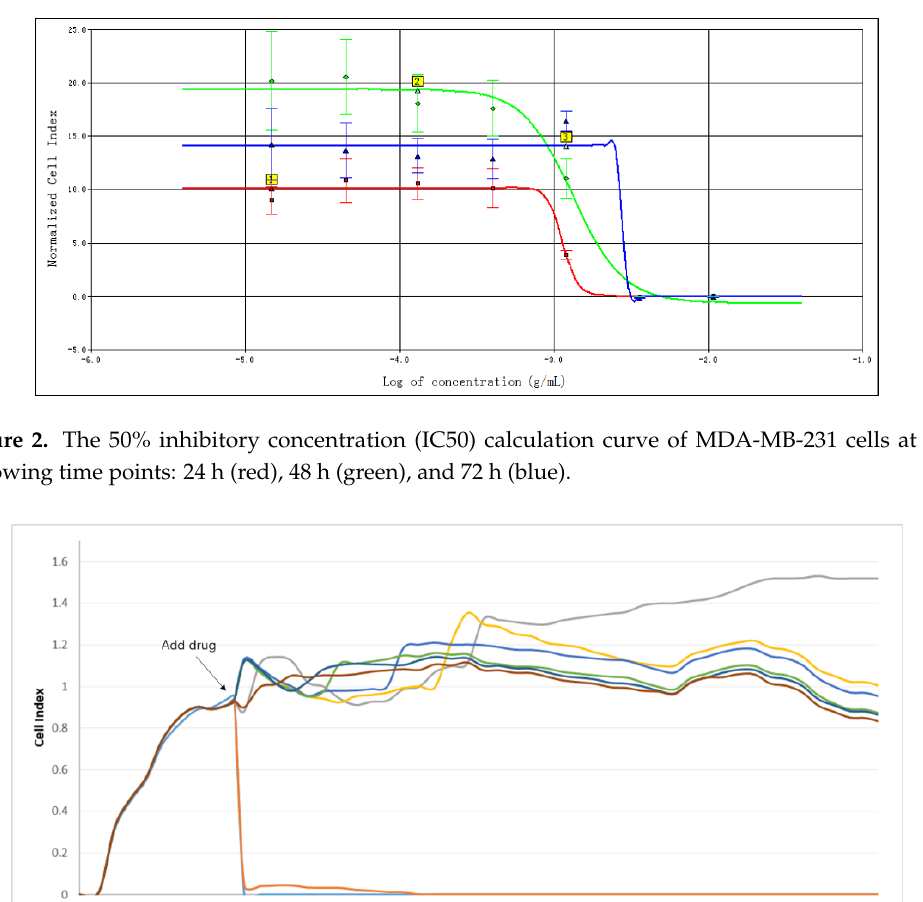
Figure 1. The IC50 values of CDDP on different cell lines at the given time points (24 h, 48 h, 72 h). Data are expressed as x ± s ( n = 3).